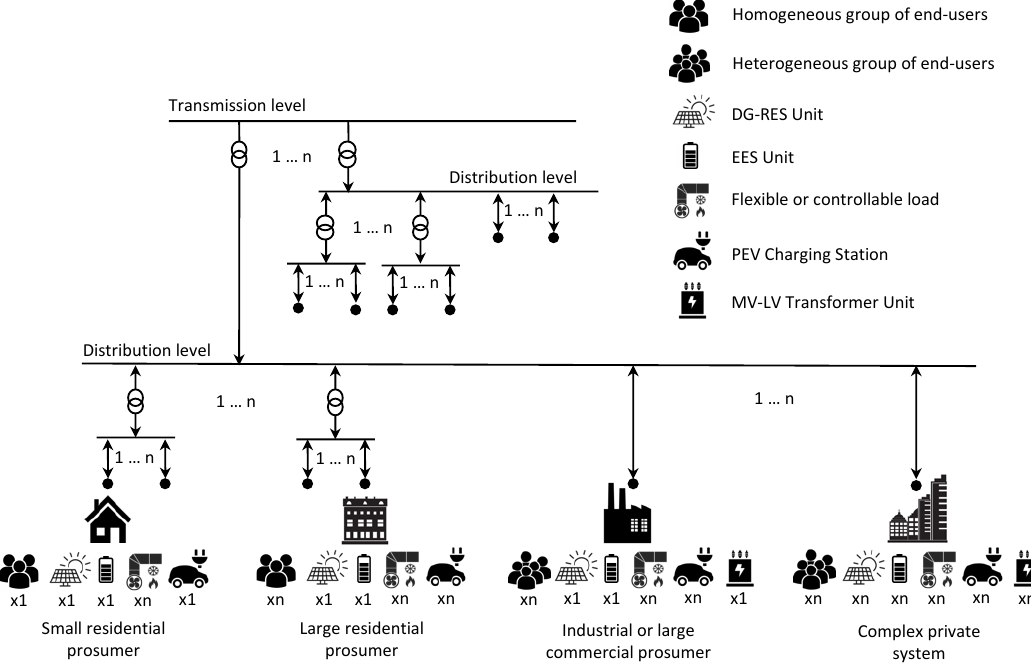
Figure 4. Schematic representation of the physical aggregation levels of DERs and prosumers in the electrical grid domain. EES: electrical energy storage; DG: distributed generation; MV: medium voltage; LV: low